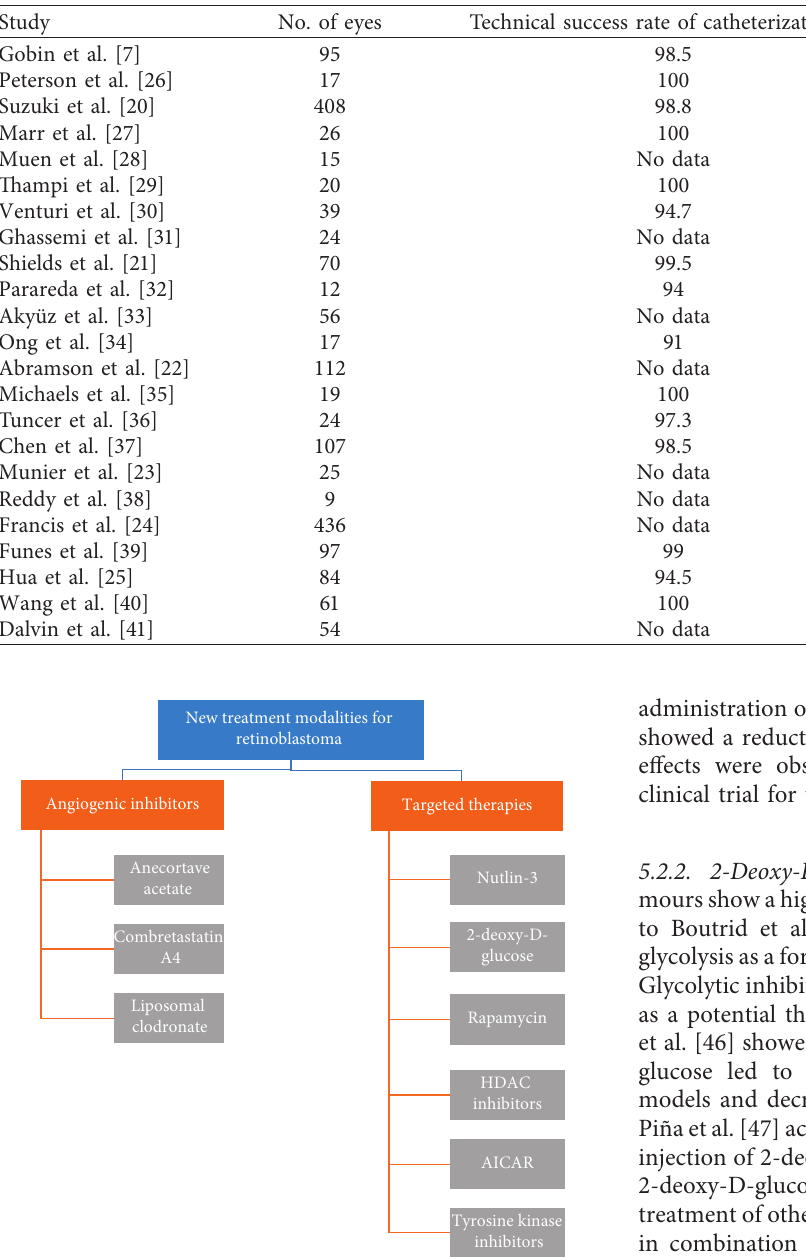
Figure 8: Summary of new treatment modalities for retinoblas- toma [42–44].